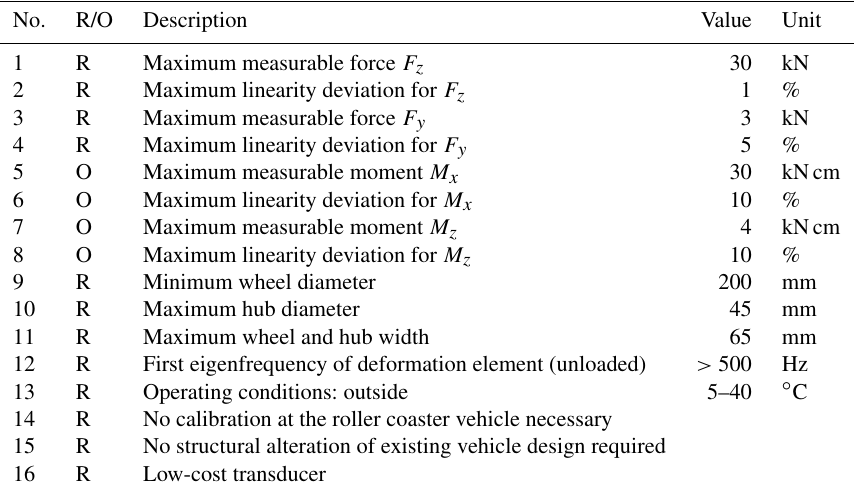
Table 2. Transducer specifications.